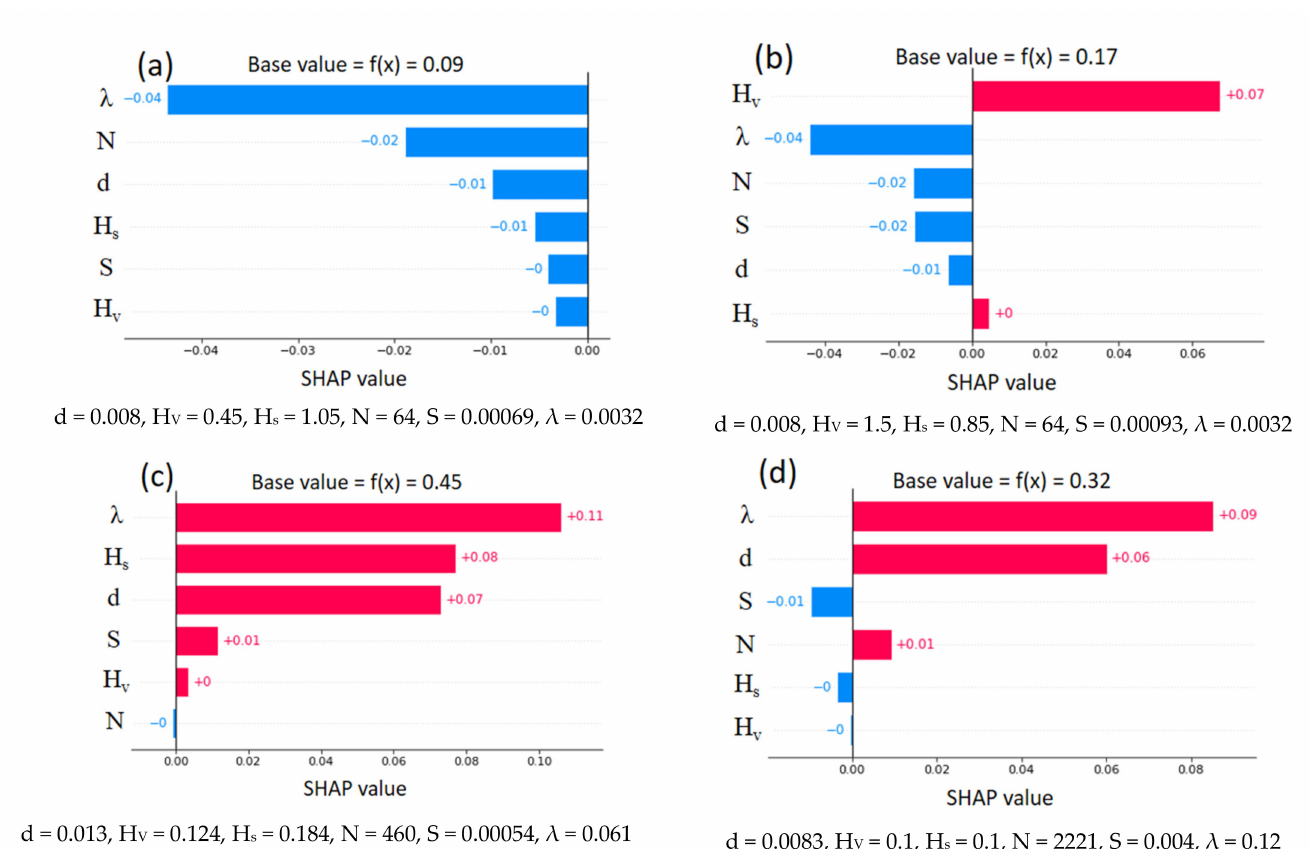
Figure 18. Instance-based SHAP explanation for f S (XGBoost